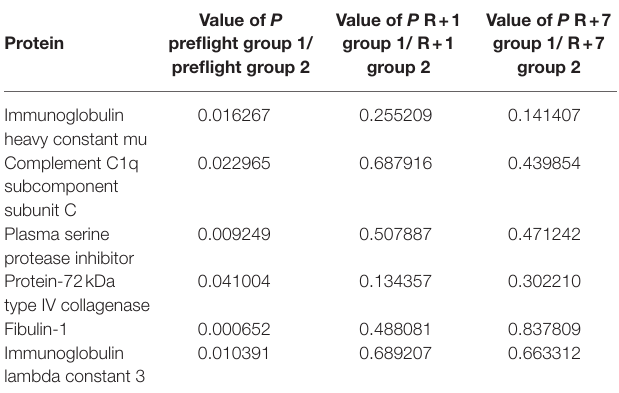
TABLE 1 | The reliability of differences in the level of proteins between the groups in the baseline period, on the 1st and the 7th days after the mission. Value of P Protein preflight group